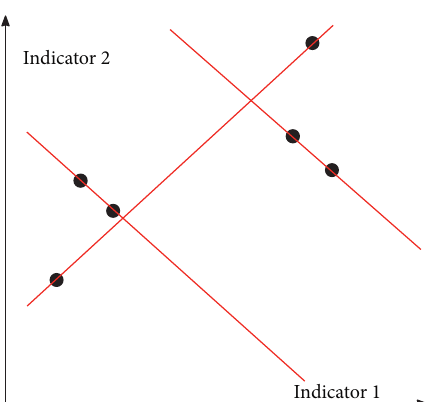
Figure 8: Schematic diagram of reverse sequence caused by im- proper relative